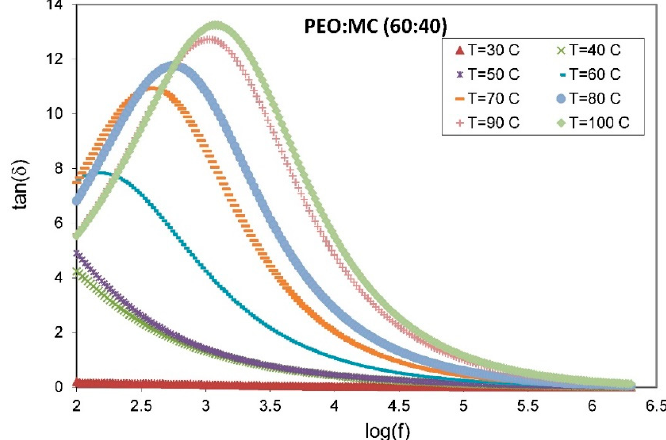
Figure 10. The variation of tan δ with frequency for the 60:40 weight ratio PEO:MC blend sample with